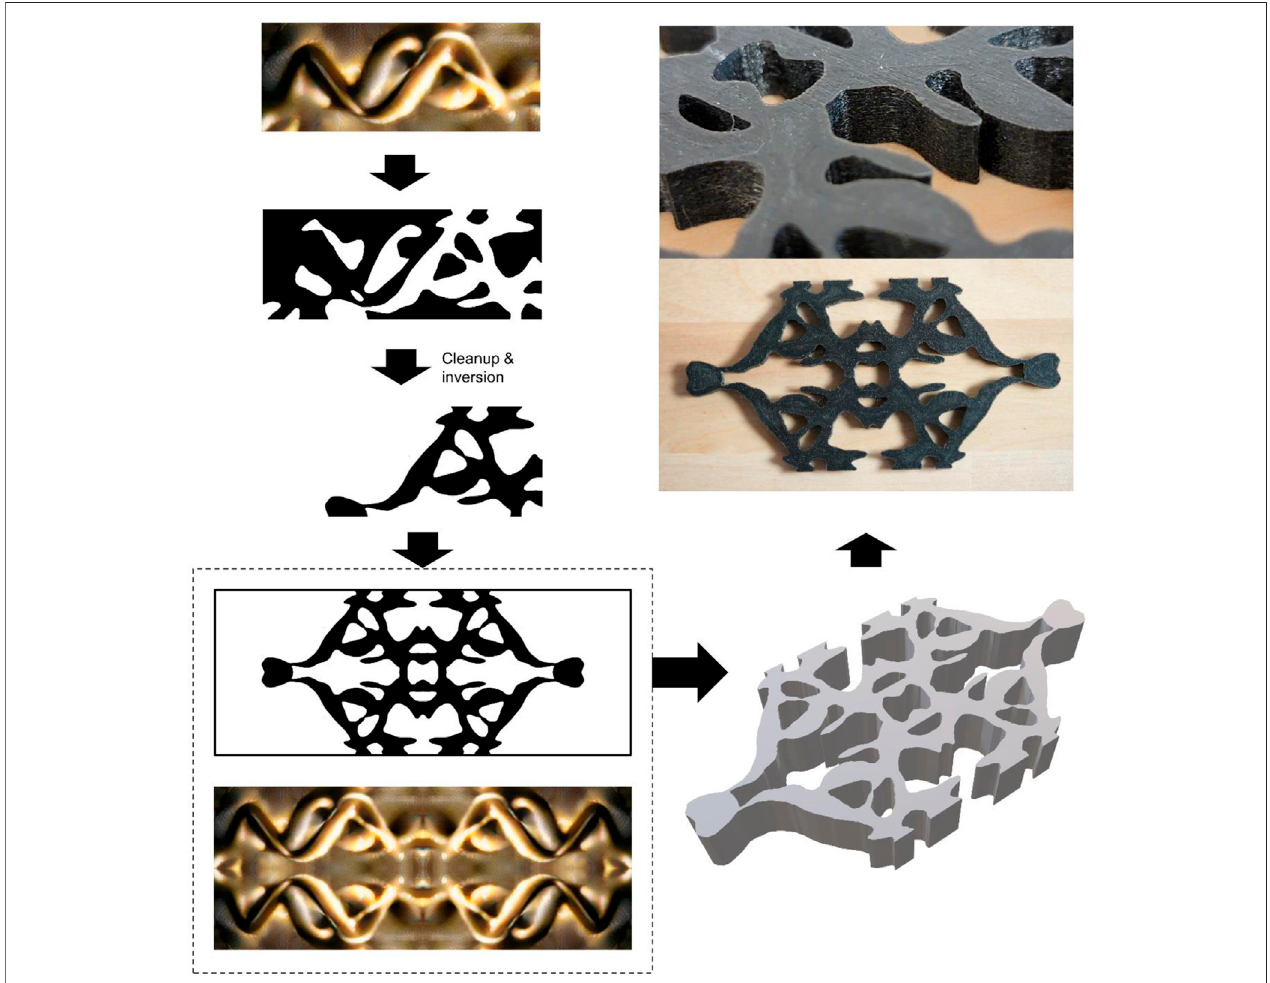
FIGURE 8 | Exploiting one of the material designs shown in Figure 7 and extraction of a periodic structure with a continuous geometry and any material islands removed. The resulting design is slightly compressed in the horizontal direction to achieve a more square-like fi nal design. Moreover, one alteration from the original designisimplemented,where theverythin section atthe left/right isthickened slightlyforbetterprintabilityandmechanical stability. The fi nal designisthen printedusing polyurethane, and used for mechanical testing. The resulting design represents a simple topological mechanism. Movies M1-4 show results of Finite Element simulations and experimental analysis, following the analysis depicted in Figure 9 . The lower left panel shows the original (bottom) and fi nal design (top), after the symmetry operations de fi ned in Figure 4C have been applied.